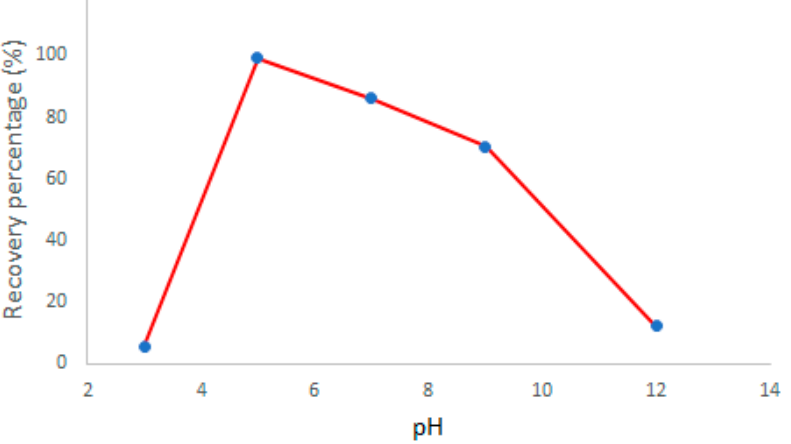
Figure 4. Recovery percentage of MG, related to the color intensity of channel R, as a function of pH. Using 2.0 mg of polyimide nanofiber in contact with 50.0 mL of MG solution at 0.1 mg/ L.